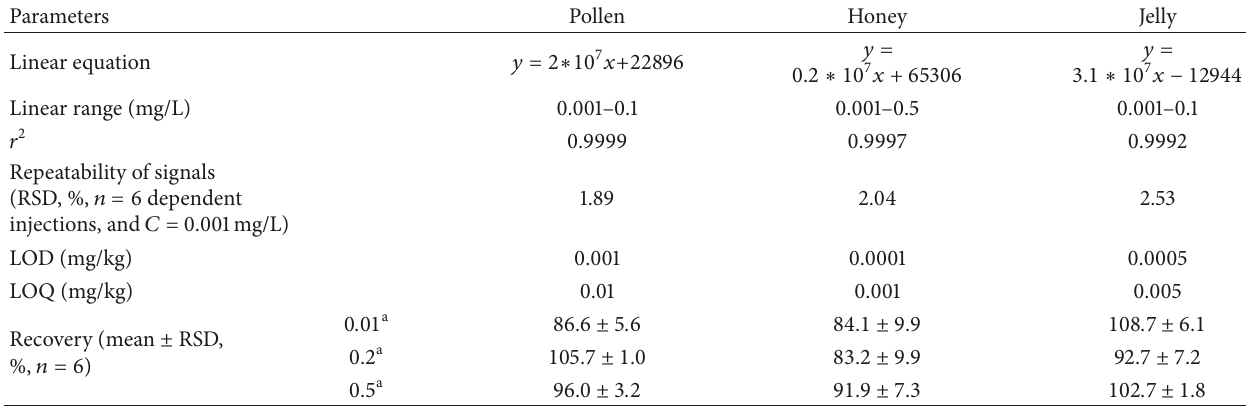
Table 3: Partial validation parameters of triadimefon added in different blank samples.